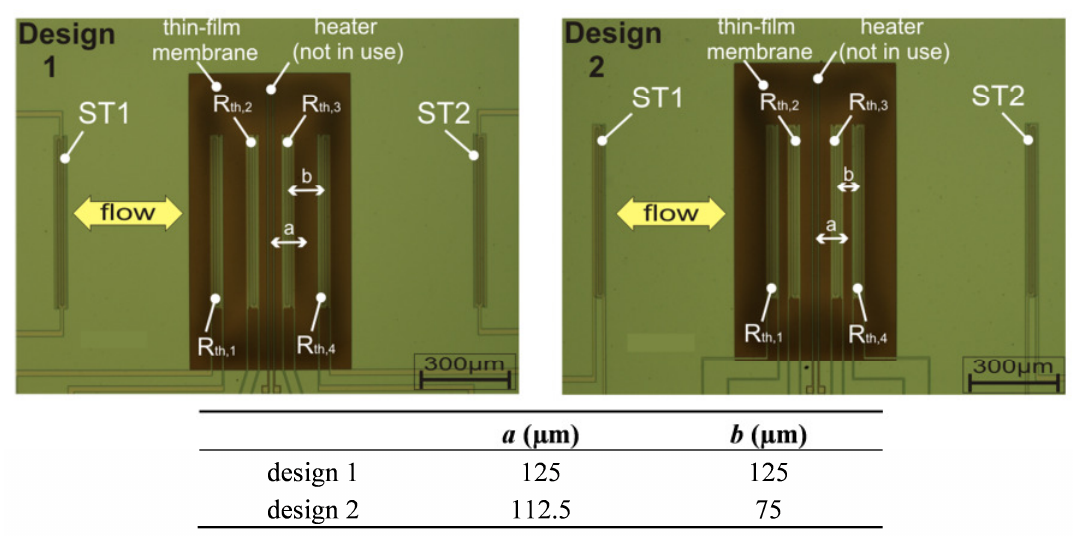
Figure 3. Photomicrograph of the flow sensor chip (design embodiment 1 and 2). Membrane size: 0.5 × 1 mm 2 . The table shows design variations (distances a , b